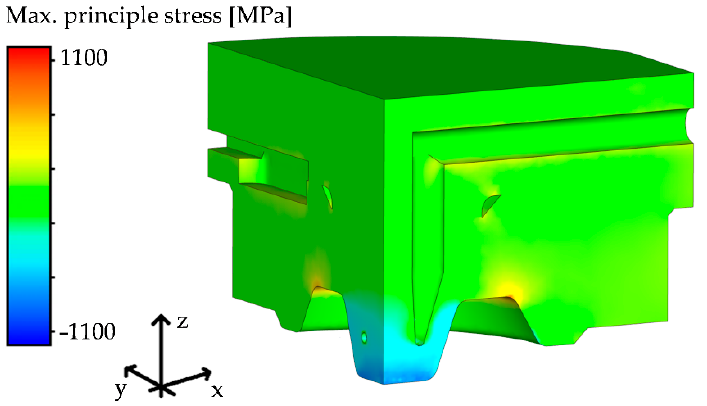
Figure 8. Example of the simulation result of the max. principal stress of Variant 06 at 100.0% stroke.